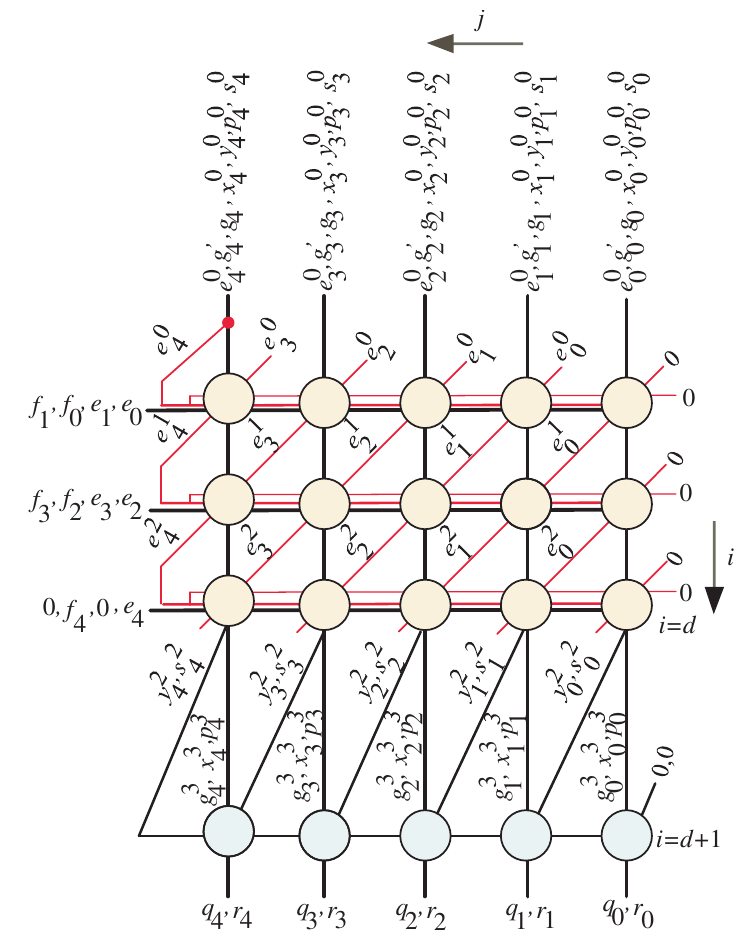
Figure 1. DG of the bipartite multiplication-squaring algorithm for n =